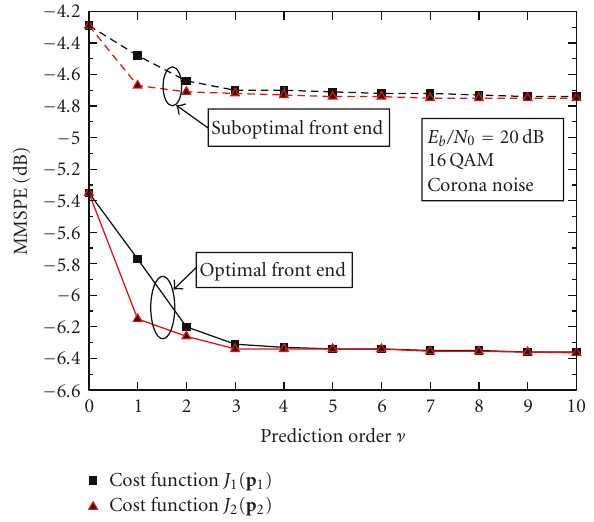
Figure 8: MMSPEs, normalized to the power of the signal s i ( c i as a function of the prediction order ν , assuming a 64 QAM con- stellation, signaling frequency f s = 64 kHz, and carrier frequency f c = 340